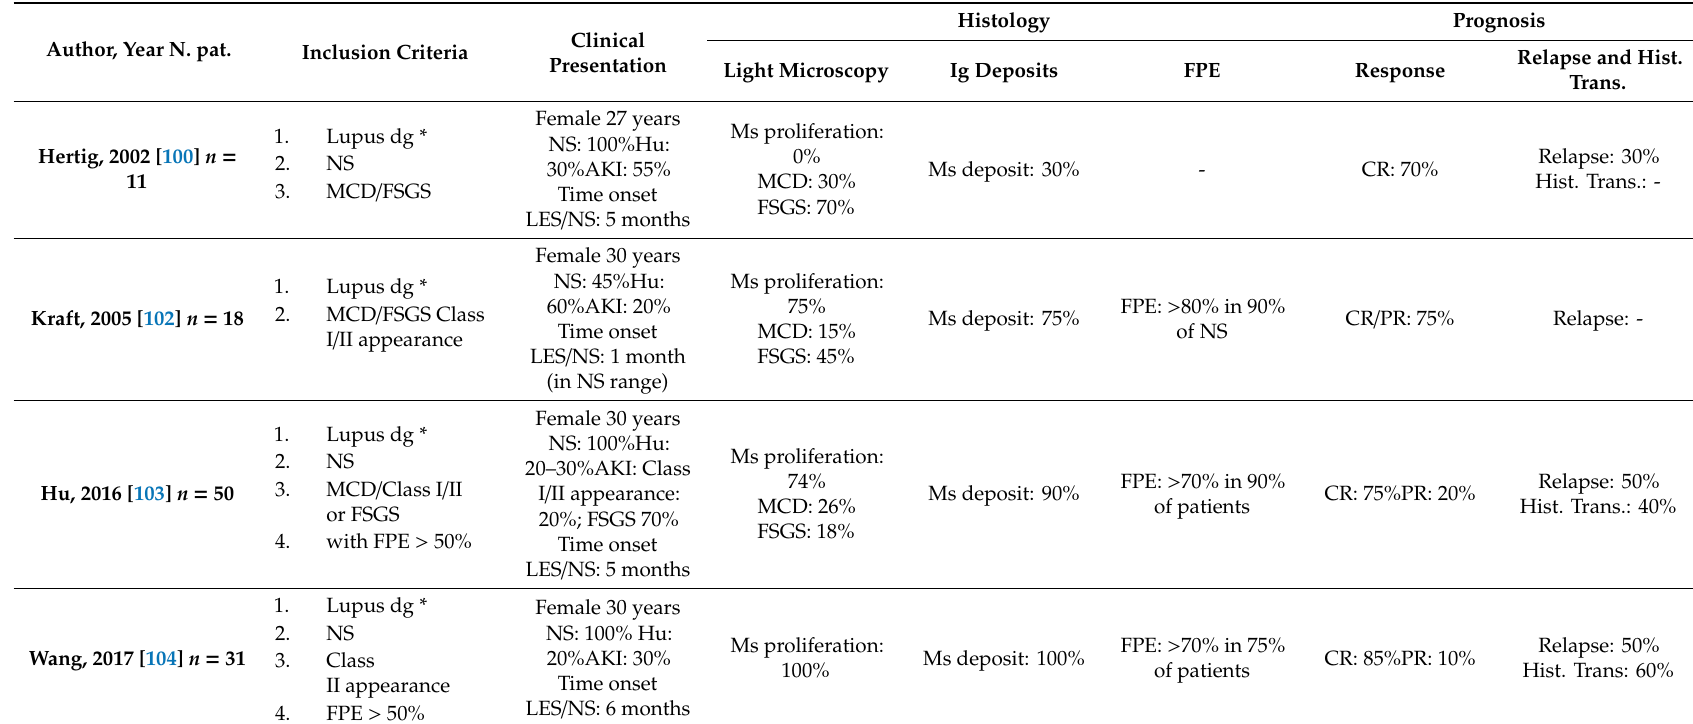
Table 2. Published studies on lupus